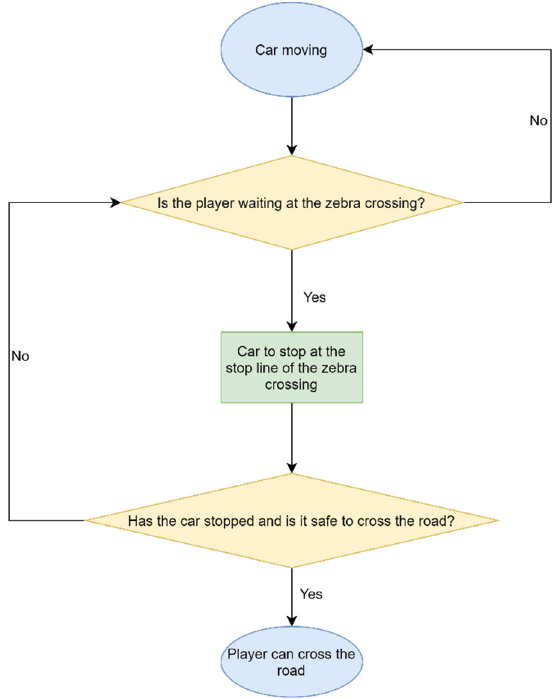
Figure 6. Flowchart of car behaviors in zebra crossing